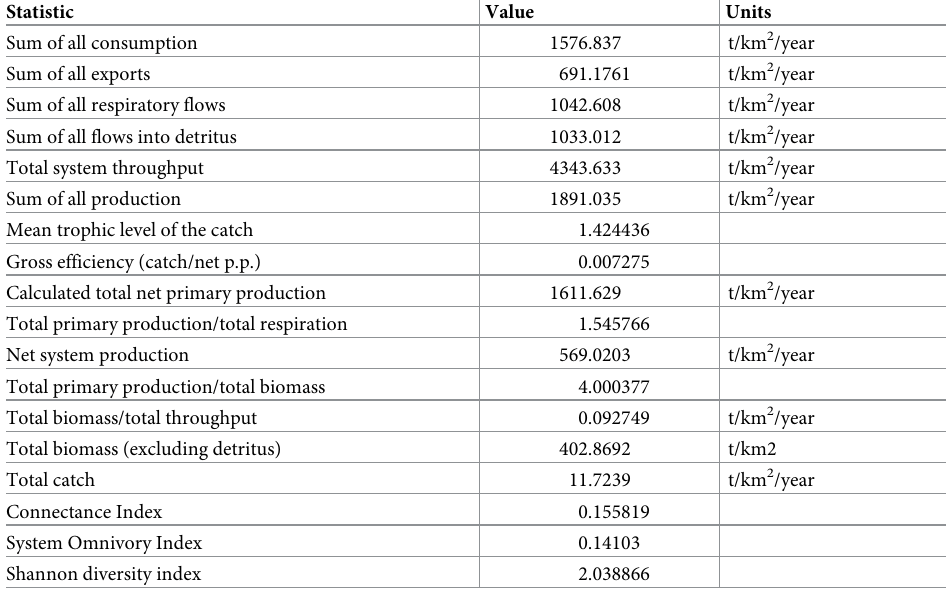
Table 2. Ecological indicators related to the food web structure of the Isla Natividad model, statistics, and net- work flow